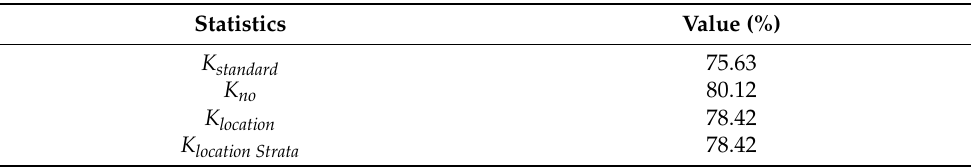
Table 13. Statistical validation of the CA-Markov Chain